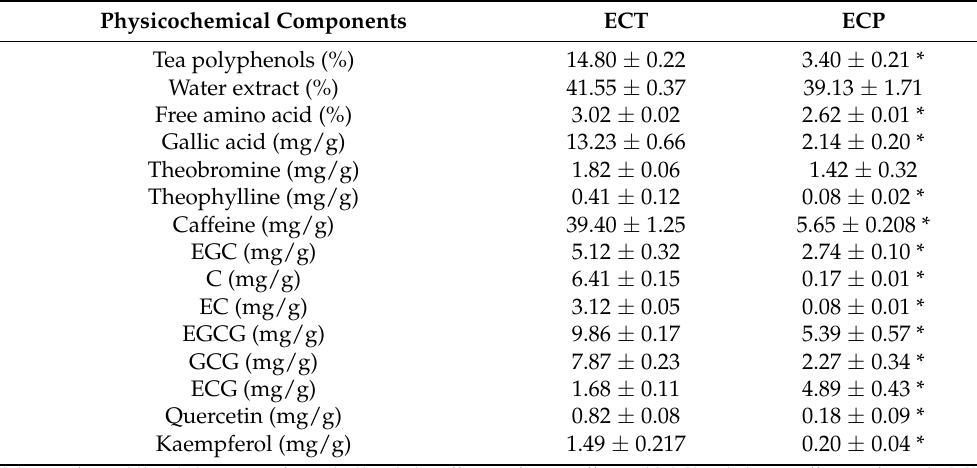
Table 1. Change of physicochemical components of ECT and ECP.